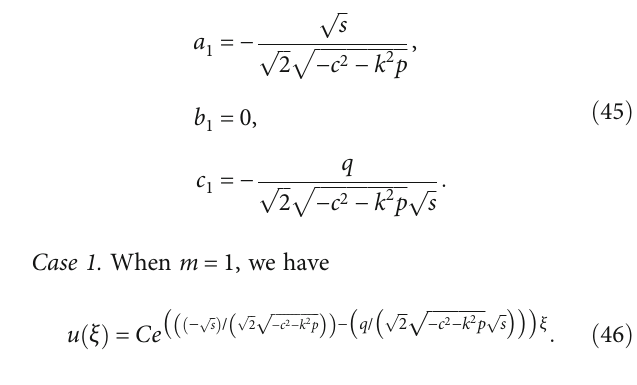
(cid:9) (cid:10)(cid:9) (cid:10)(cid:9) (cid:10) ffiffiffiffiffiffiffiffiffiffiffiffi p ffiffi p − c 2 − k 2 p ξ s